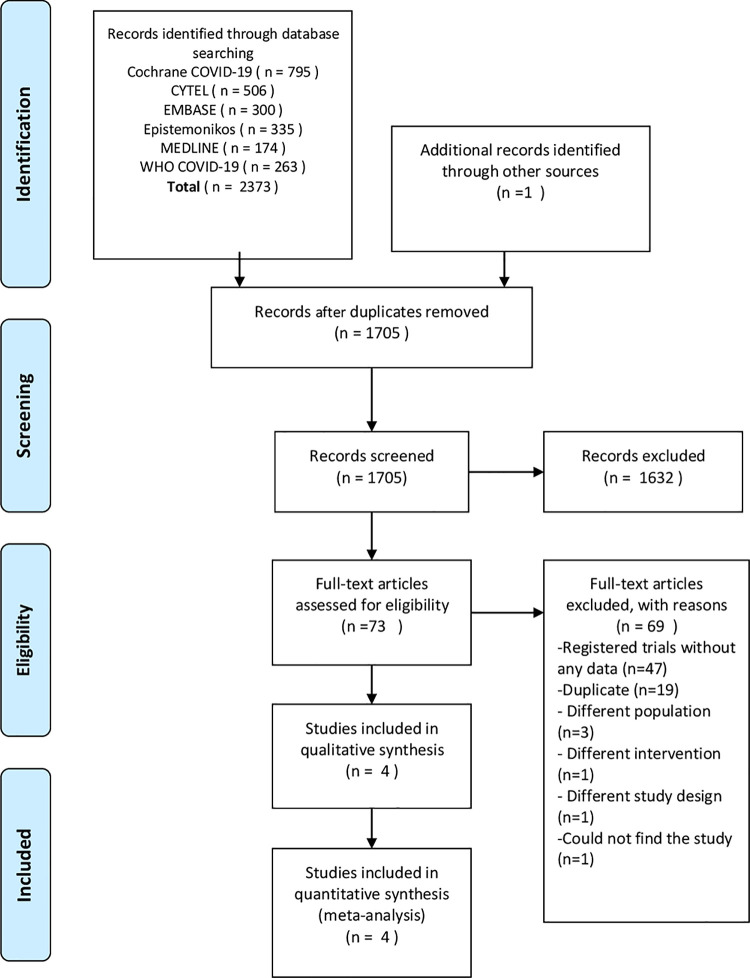
Prisma flow diagram.